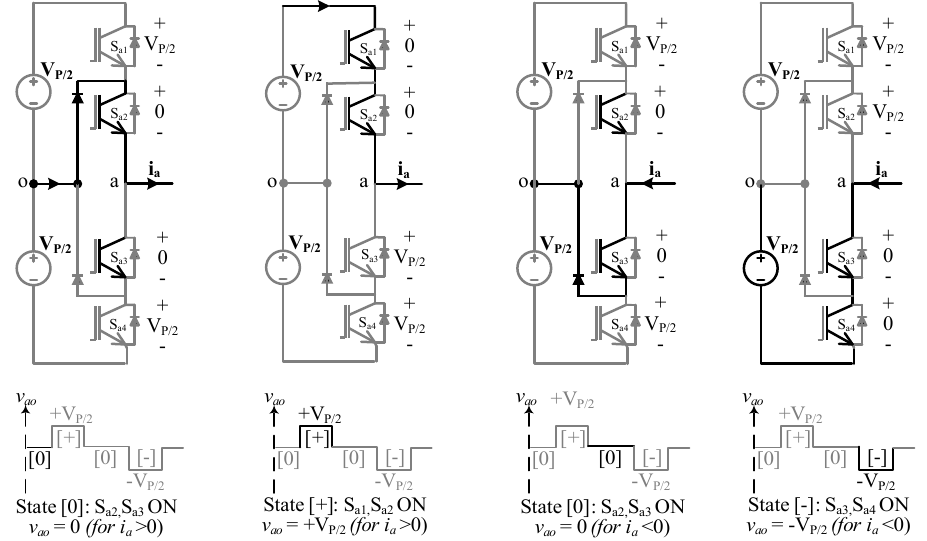
) synthesized from leg- a of a (cid:3028)(cid:3042)